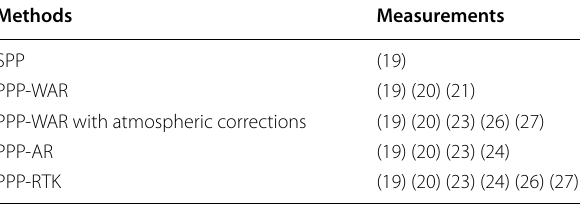
Table 1 Measurements used in different positioning models